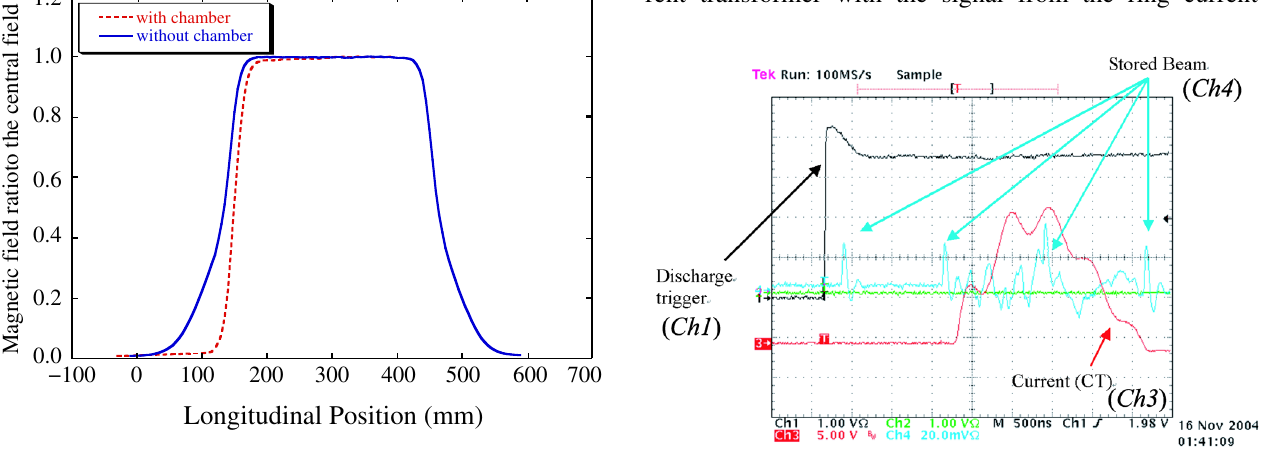
FIG. 20. (Color) Typical waveform in the adjustment of excita- tion timing of the PQM measured using a digital oscilloscope. The lines represent a discharge trigger signal ( Ch 1 : black), a signal from the current transformer of the ring ( Ch 4 : cyan), and a signal from the current transformer of the PQM power supply ( Ch 3 : red). The peaks in ( Ch 4 : cyan) line indicate the stored bunch.